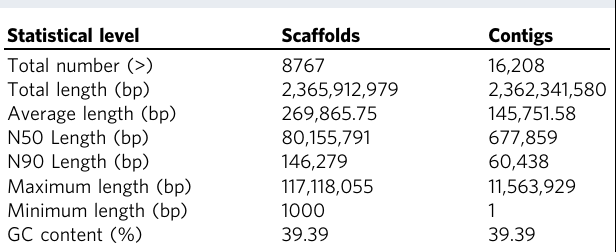
Table 1 Statistics of the de novo genome assembly of C. appendiculata